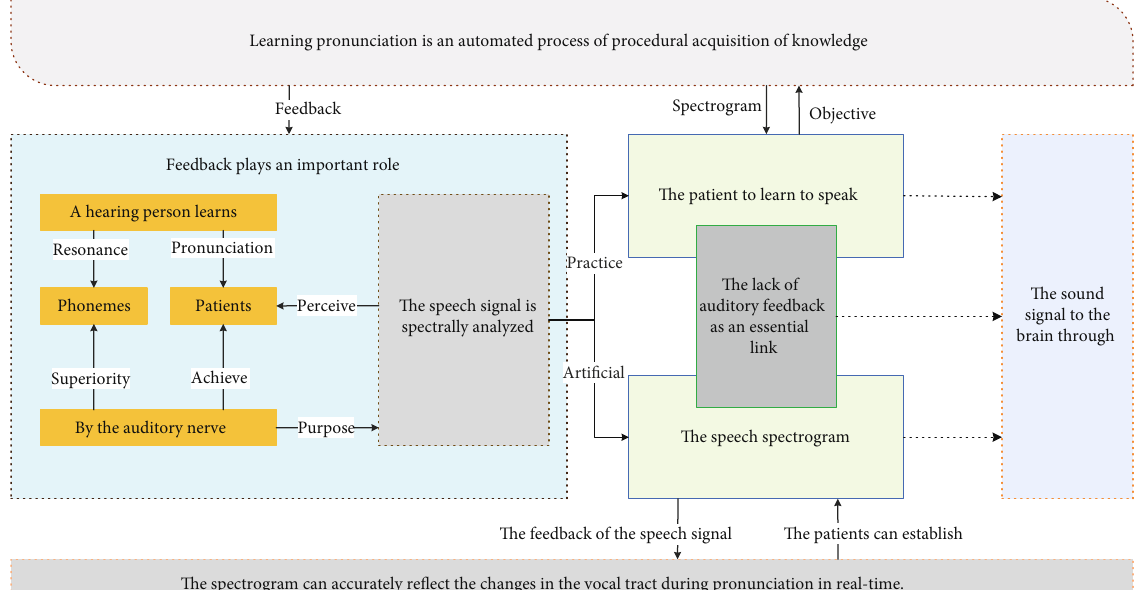
Figure 6: Flow chart of patient rehabilitation treatment.